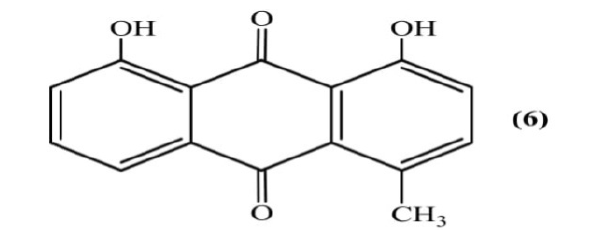
FIGURE 2 | Anthraquinone.